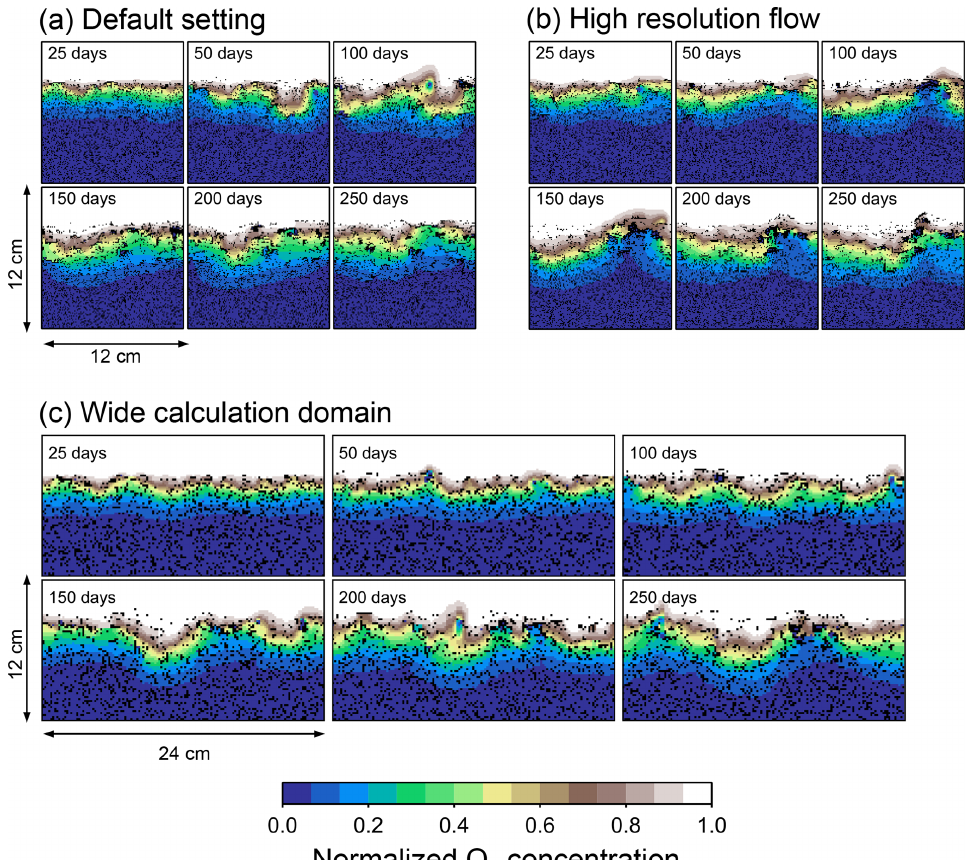
Figure B1. Time evolution of oxygen profiles in simulations (a) with the default settings, (b) assuming a higher resolution (480 × 480) for the water flow calculation with otherwise default settings, and (c) assuming a wider calculation domain (24 × 12cm 2 ) and two deposit feeders with otherwise default